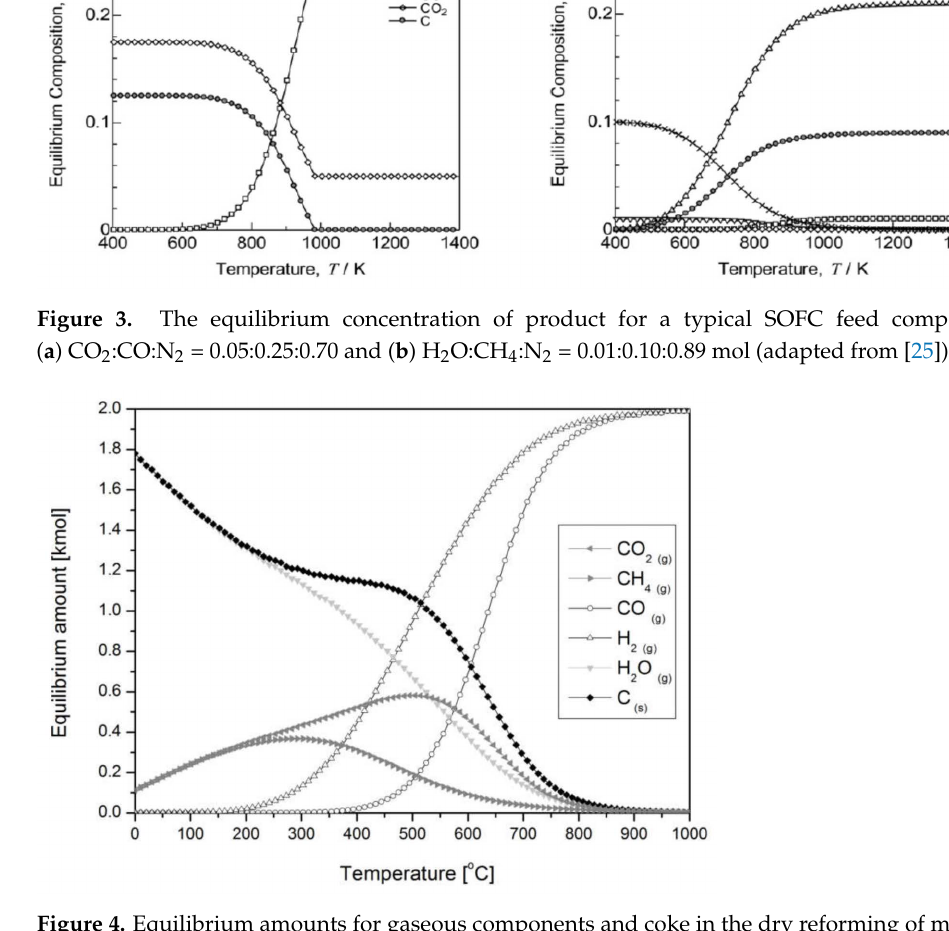
Figure 4. Equilibrium amounts for gaseous components and coke in the dry reforming of methane process (CH 4 /CO 2 /Ar = 1/1/8, p = 1 bar) (adapted from